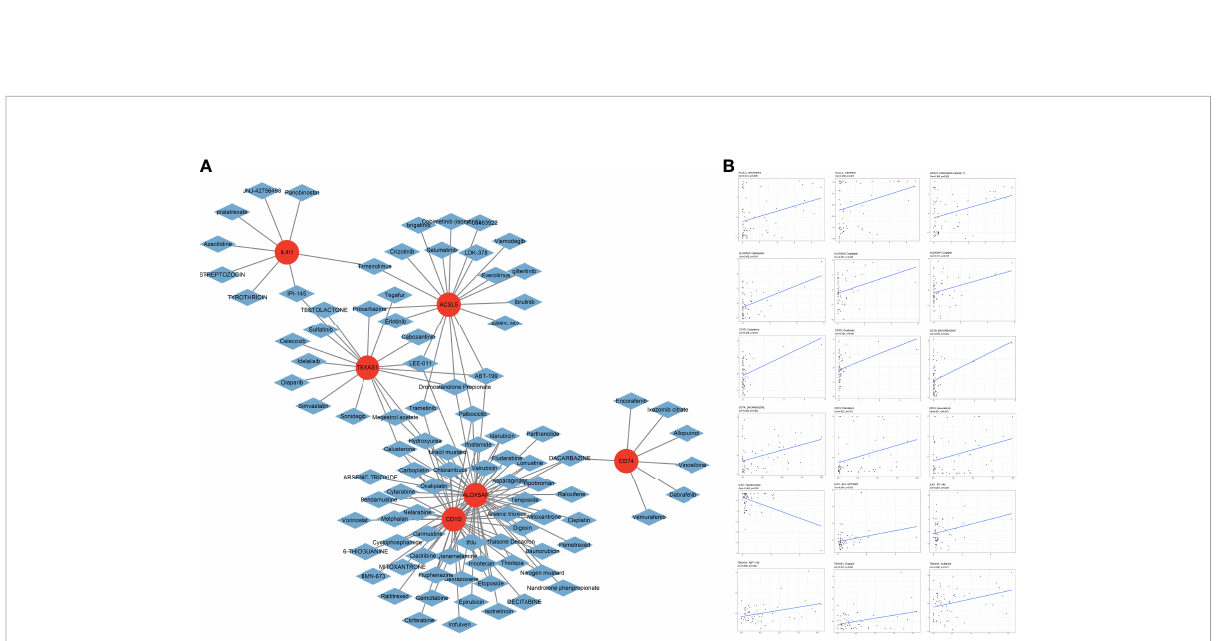
FIGURE 11 Chemotherapy sensitivity. (A) Chemotherapy sensitivity network shows that CM expressing the 6 genes has signi fi cant sensitivity to some chemotherapy drugs. (B) The scatter plot of the relationship shows that increased expression of ACSL5, ALOX5AP, CD1D, CD74, IL4I1 , and TBXAS1 is associated with sensitivity to trametinib, selumetinib, cobimetinib, carboplatin, oxaliplatin, cisplatin, and